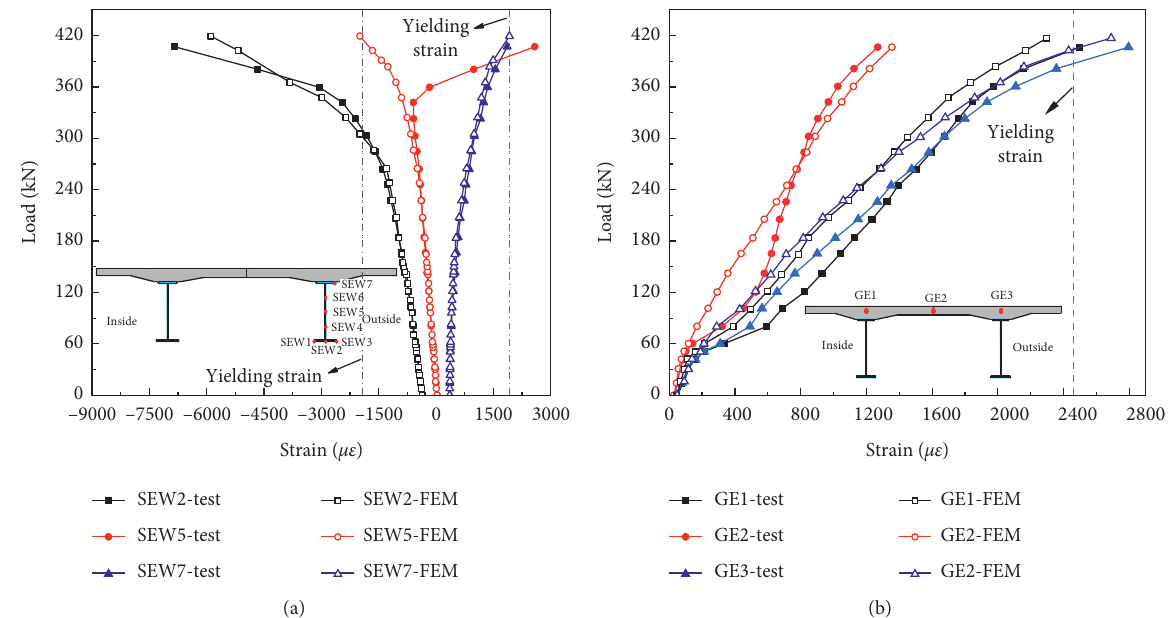
Figure 12: Strain analysis results at the mid-support section E: (a) load-strain relation of steel main girders; (b) load-strain relation of longitudinal reinforcements.